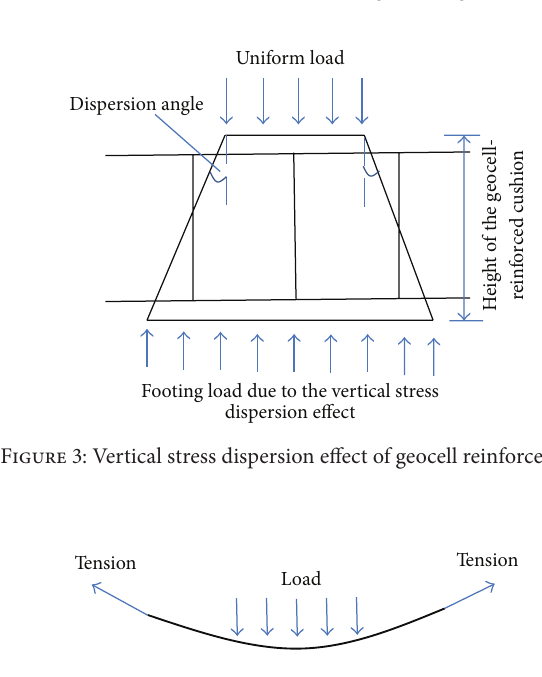
Figure 4: Membrane effect of geocell